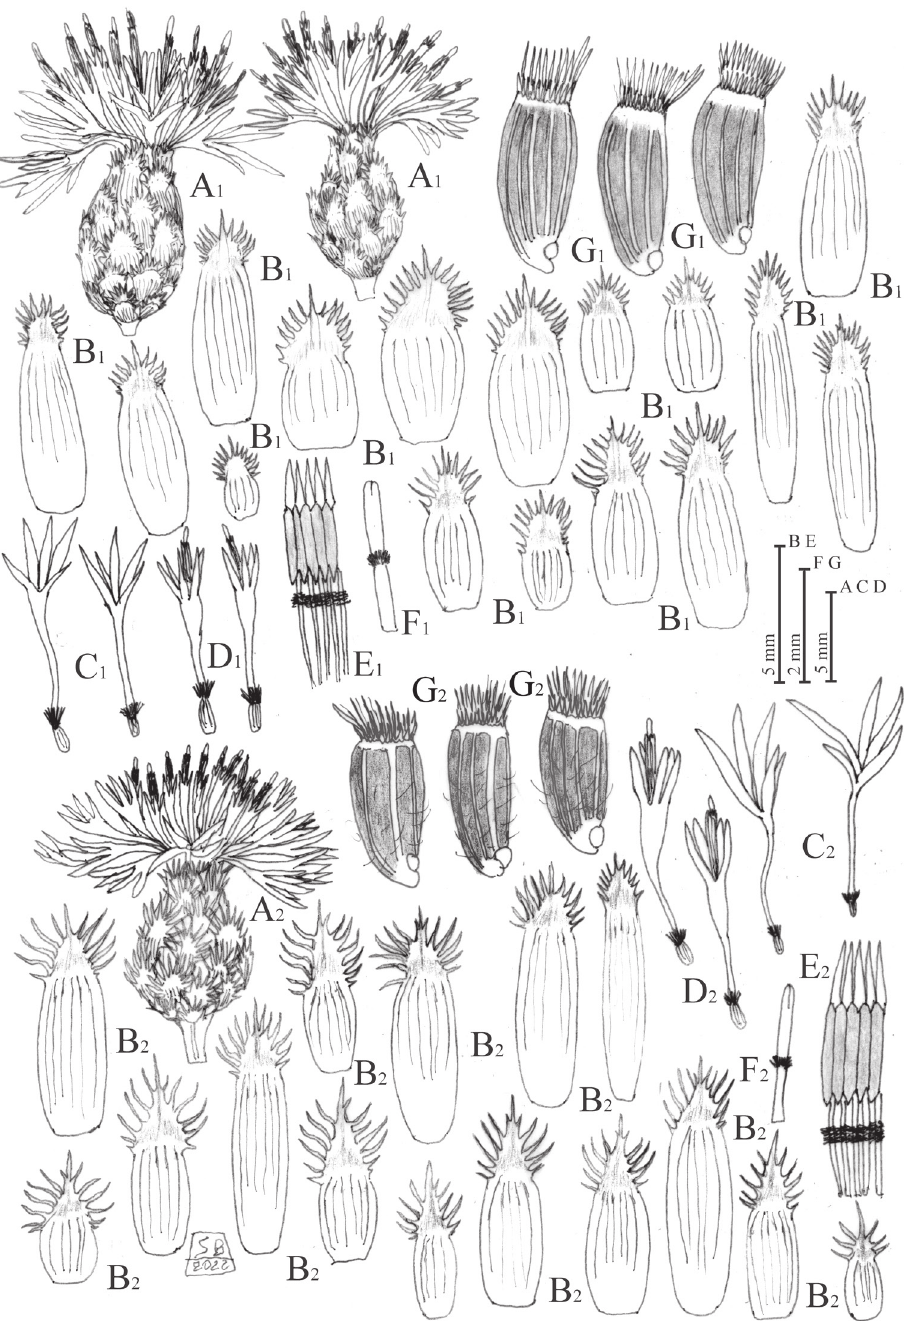
Figure 6. Centaurea glaberrima (1) and C. divergens (2) A capitula B phyllaries C outermost sterile flo- rets D disc florets E stamens upper part F